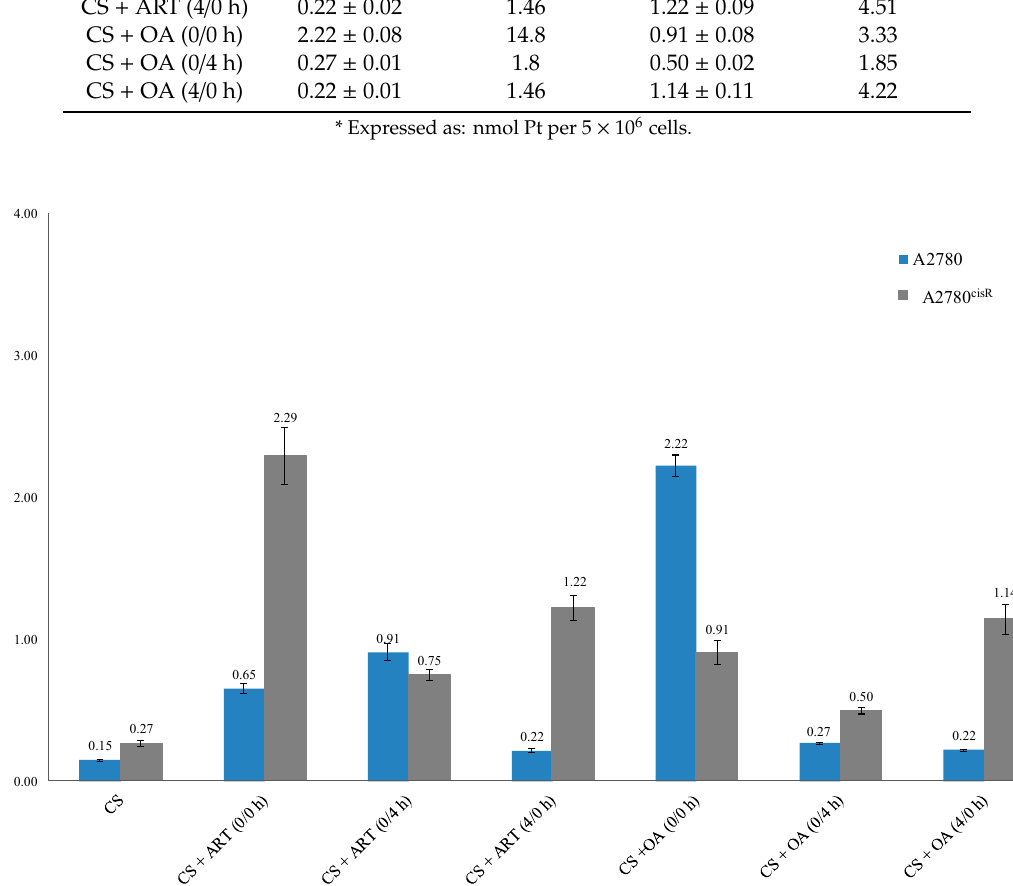
Figure 2. Graphical representation of combination indices (CI) applying to binary combinations of CS with OA and ART at ED50 (where drugs were added in equipotent ratios based on IC 50 values).